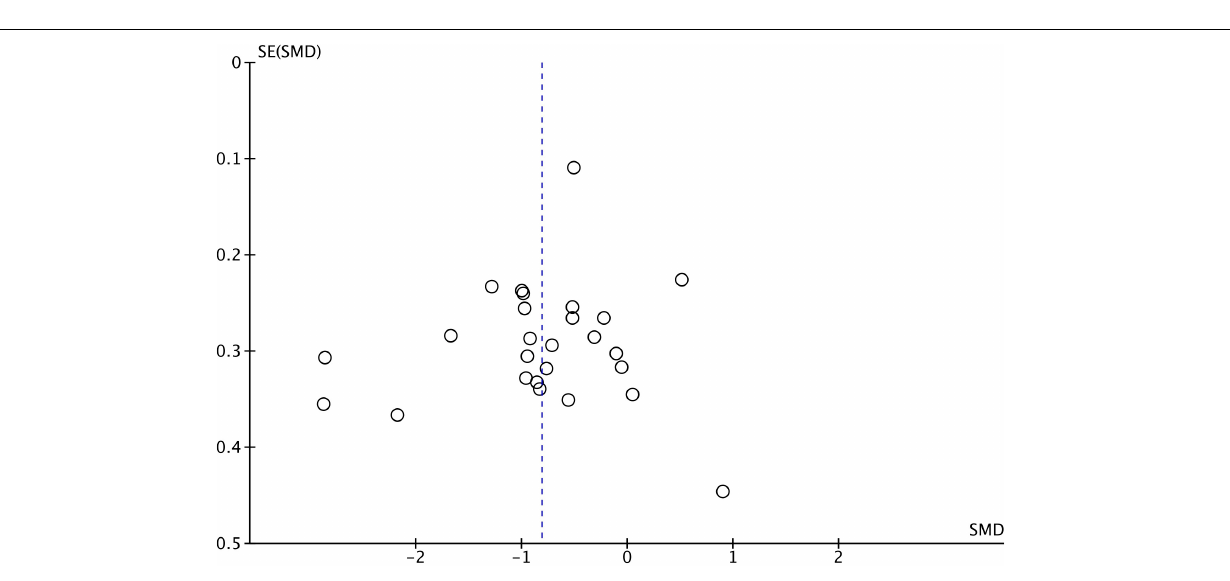
FIGURE 3 | Funnel plot–theory of mind funnel plot for 26 studies comparing theory of mind performance between ASD and TD. SMD, standard mean difference (effect size); SE, standard error. Positive effect sizes indicate superior performance in ASD. The solid vertical line indicates the estimate for the population effect